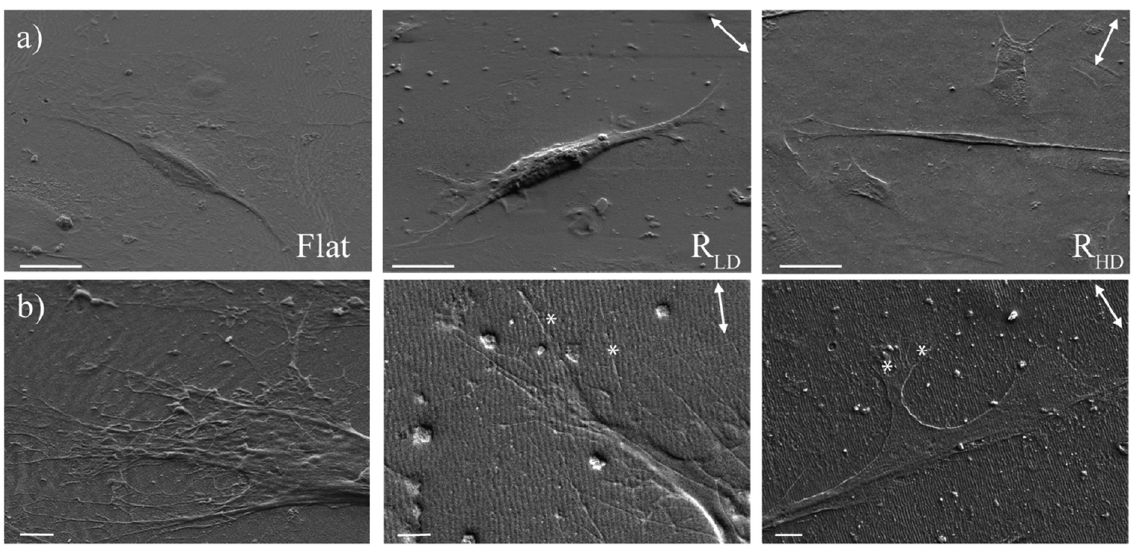
Figure 10. Low- ( a ) and high-magnification ( b ) SEM images of SCs on a flat (left) and nanorippled surfaces with 270 nm (middle) and 290 nm periodicity (right). Scale bars are 100 µm (first row) and 2 µm (second row). White asterisks indicate parallel alignment of filopodia with regard to the ripple direction as indicated by the white arrows. Republished with permission of The Royal Society of Chemistry, from Ref. [133]; permission conveyed through Copyright Clearance Center, Inc.